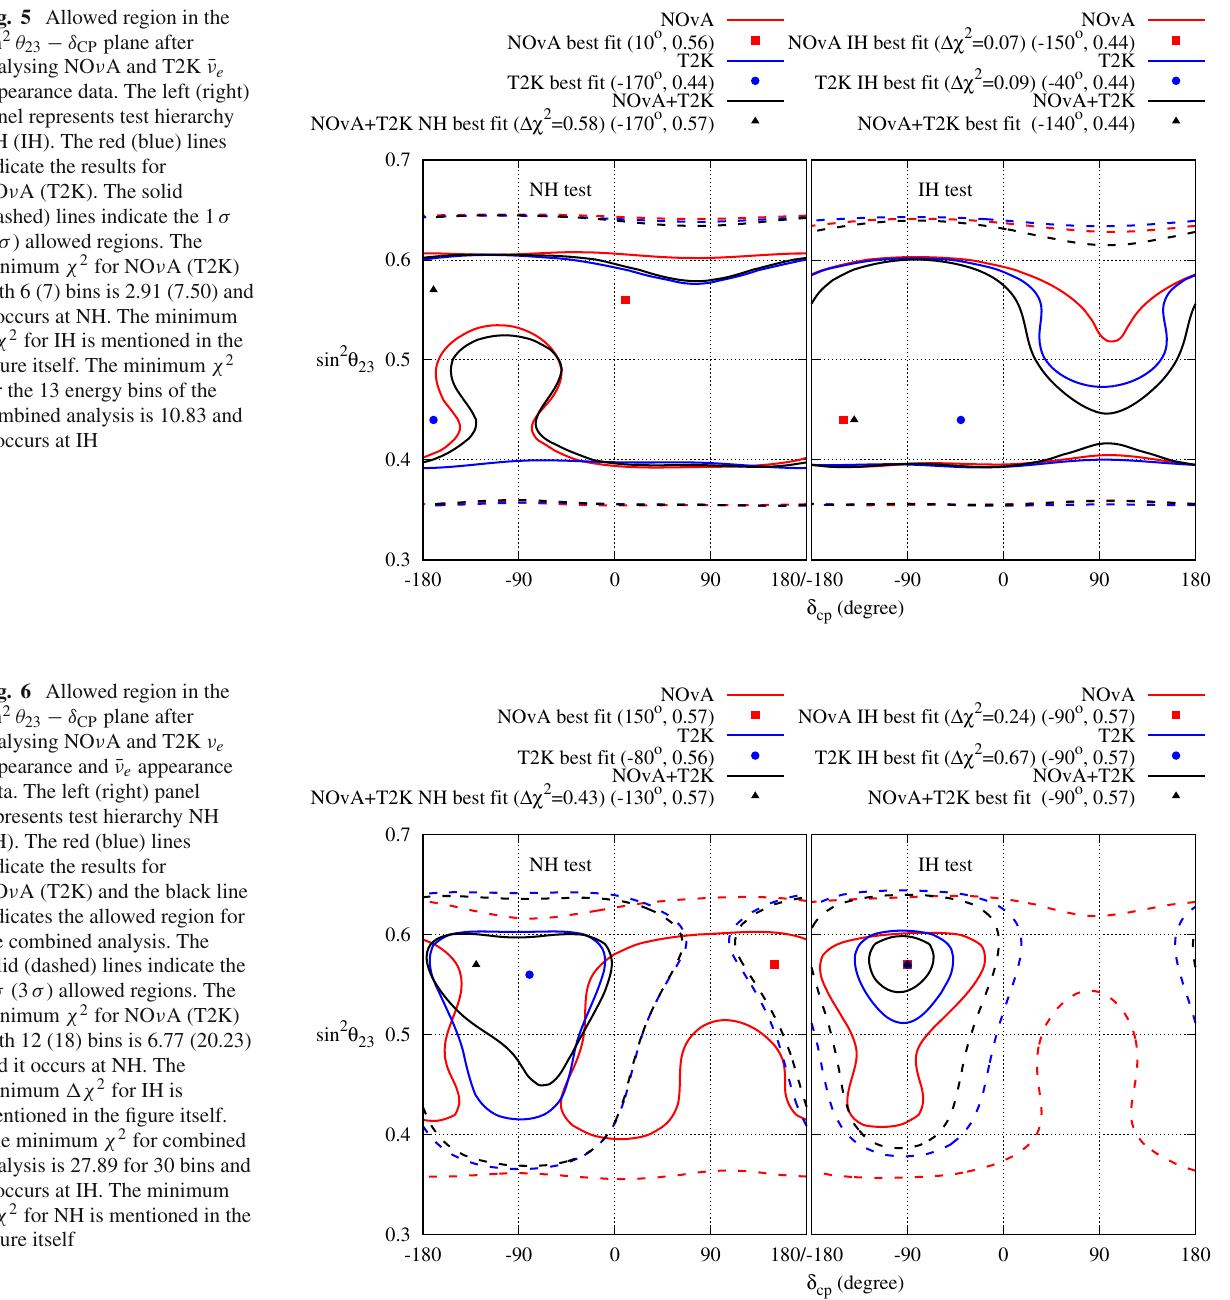
Fig. 6 Allowed region in the sin 2 θ 23 − δ CP plane after analysing NO ν A and T2K ν e appearance and ¯ ν e appearance data. The left (right) panel represents test hierarchy NH (IH). The red (blue) lines indicate the results for NO ν A (T2K) and the black line indicates the allowed region for the combined analysis. The solid (dashed) lines indicate the 1 σ (3 σ ) allowed regions. The minimum χ 2 for NO ν A (T2K) with 12 (18) bins is 6.77 (20.23) and it occurs at NH. The minimum (cid:5)χ 2 for IH is mentioned in the figure itself. The minimum χ 2 for combined analysis is 27.89 for 30 bins and it occurs at IH. The